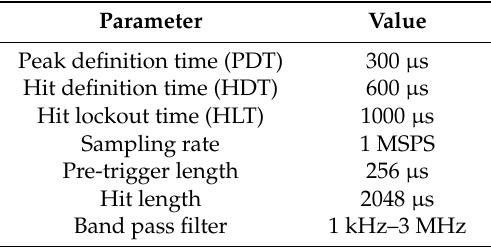
Table 2. AE (acoustic emission) software